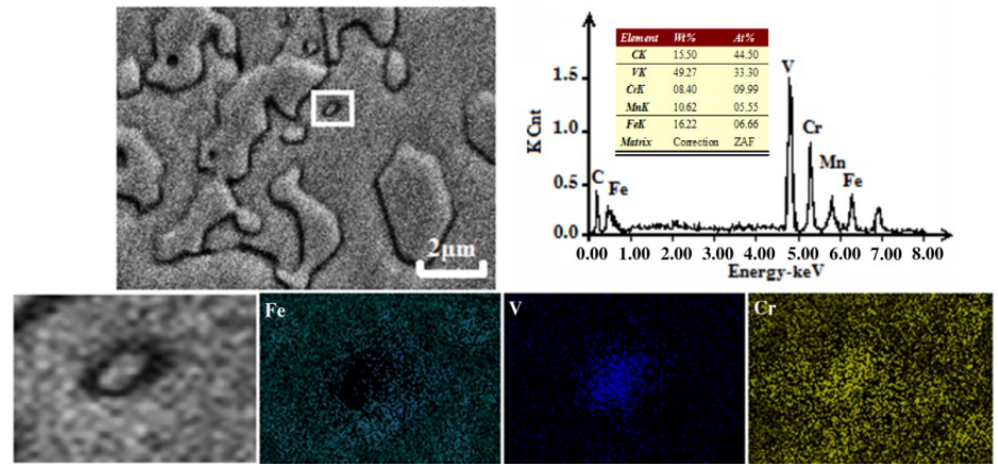
Figure 10. EDS of MC carbide in 3.6C-20Cr-Fe-2.32V hardfacing layer. Table 3. Chemical component of carbides in HCCI hardfacing layers with different V. Hardfacing Layer